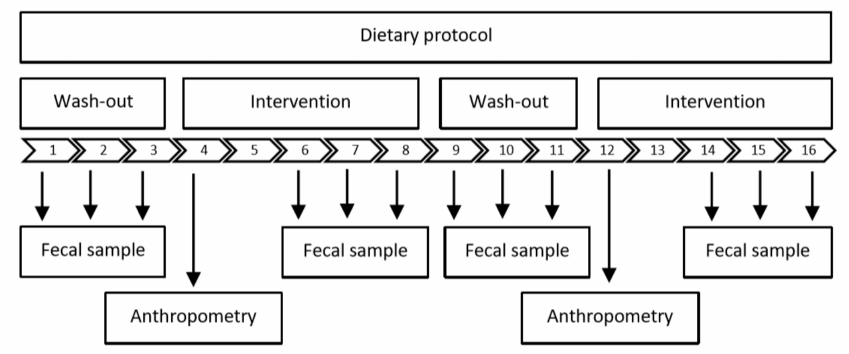
Figure 1. Study design of the food and beverage studies. Timeline and